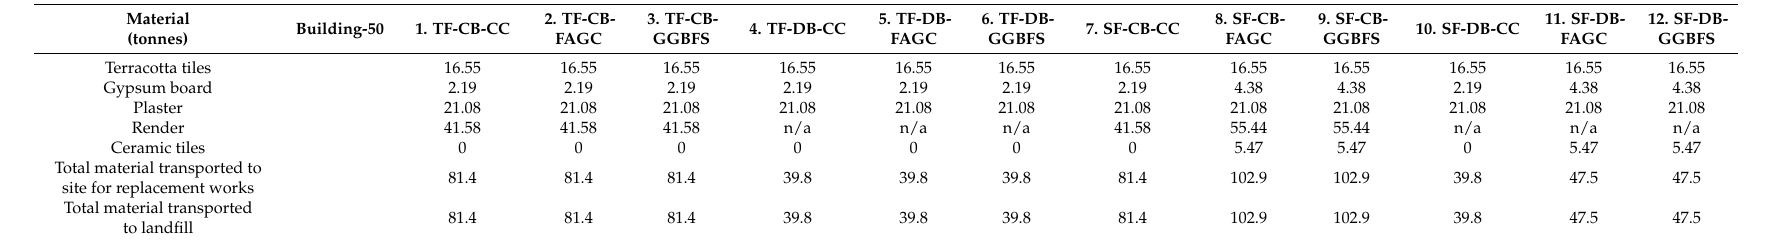
Table A2. Life cycle inventory of materials for the replacement stage of case study buildings.